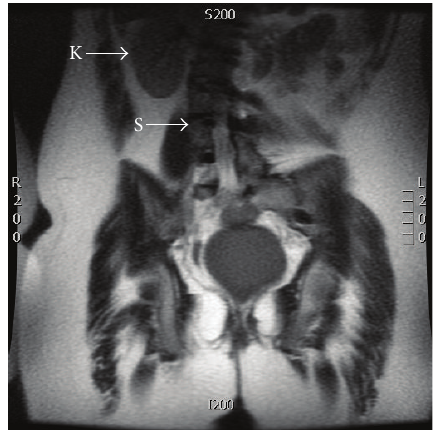
Figure 4: MRI of the lower abdomen and pelvis, demonstrating singlekidneyandscoliosis.CoronalT2image,showingrightKidney (K) only with absence of left kidney and severe scoliosis